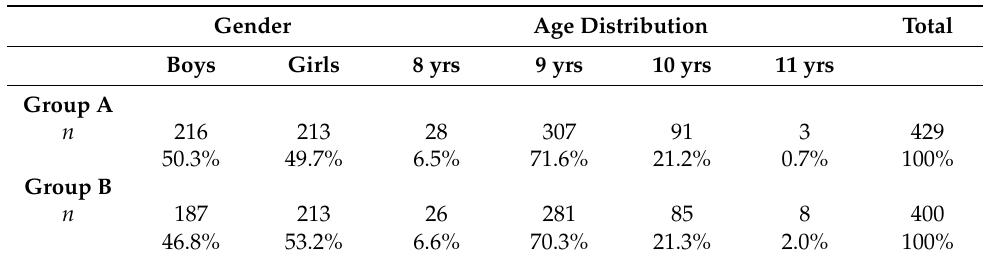
Table 1. Demographic description of schoolchildren from the parent–child pairs of Group A and Group B (gender and age distributions).